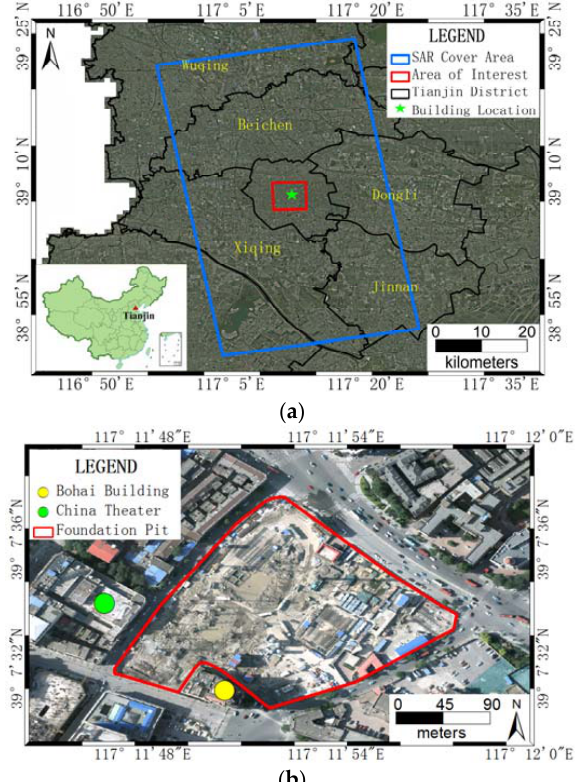
Figure 1. ( a ) Location of the AOIand coverage of SAR data for subsidence monitoring in the Tianjin region, with aerial ortho ‐ photo of 1 m as background; and ( b ) location of two experimental buildings near a foundation pit, with aerial ortho ‐ photo of 0.2 m as background.